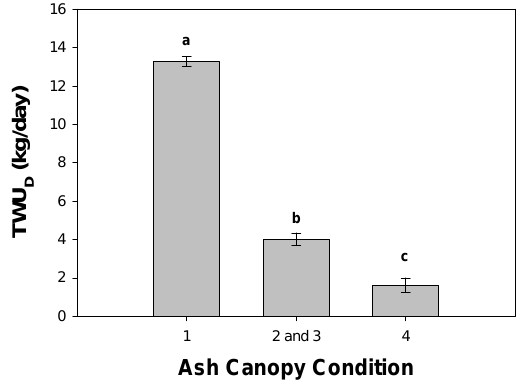
Figure 3. Mean daily sap flux (TWU D ) across trees of different ash condition classes. Letters represent significance levels determined by Tukey’s HSD pairwise comparisons ( p < 0.05), error bars denote ±1 SE.